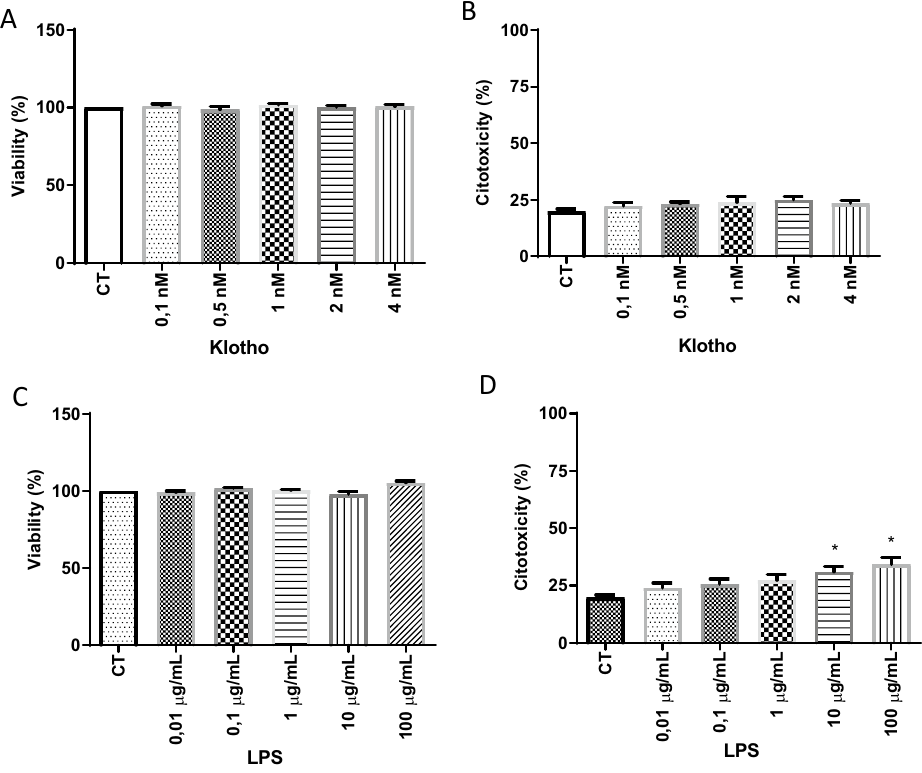
Figure 1. Effect of α-Klotho ( A , B ) and LPS ( C , D ) treatment on cell viability ( A , C ) and cytotoxicity ( B , D ) of mouse glial cells. The primary culture of glial cells was subjected to 24-h treatment with LPS in different concentrations. Cell viability and cytotoxicity were assessed by MTT and LDH assays, respectively. One-way ANOVA analysis, followed by Tukey’s post-test, *p < 0.05. Results are presented as mean ± SEM of 7 independent experiments.